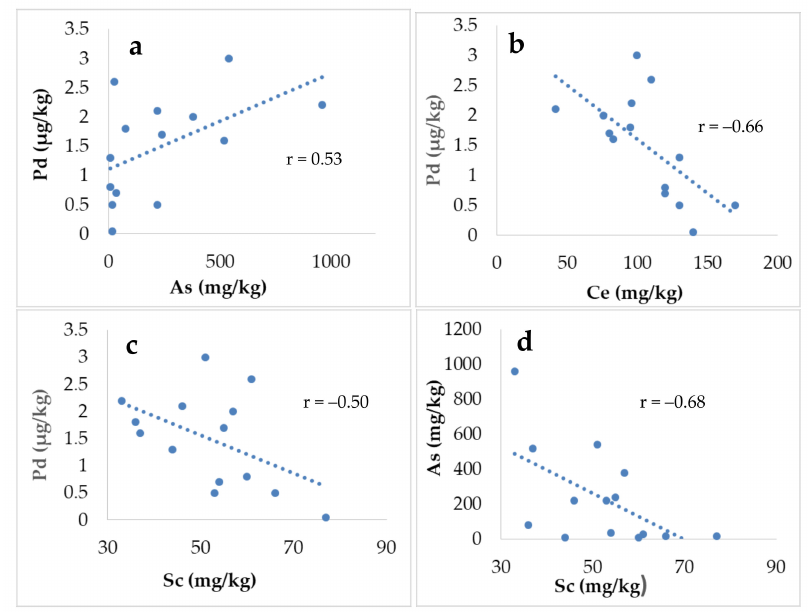
Figure 3. Plots of Pd versus As, Ce, and Sc ( a – c ), and As versus Sc ( d ) from the bauxite profile (Figure 1). Data are from Table 1. The schematic compositional variations present the Al enrichment, accompanied by REE, As, Pd, U, and TOC in the transformed multicolor ores compared to brown-red bauxite ores, and a very good correlation (r = 0.89) between Sm and Eu (Table 2; Figures 4 and 5).